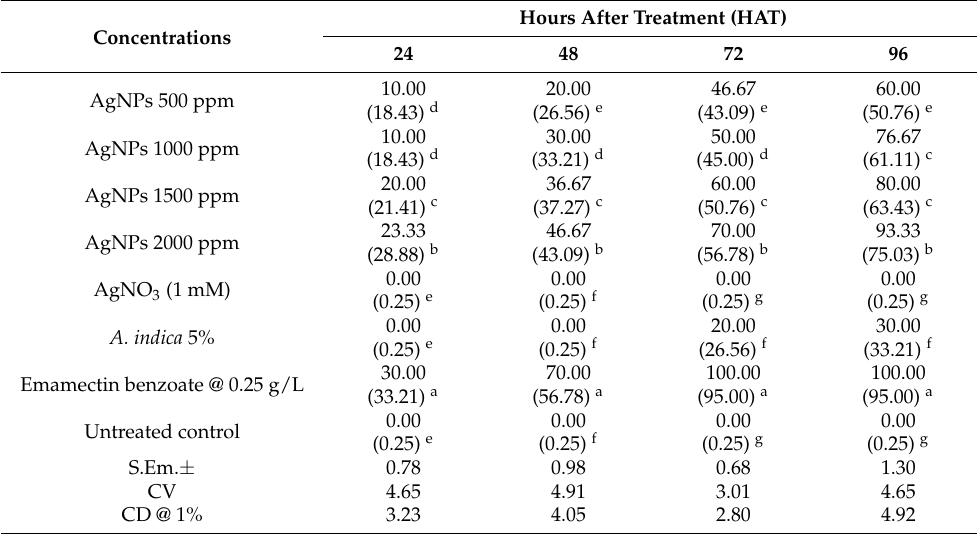
Table 1. Toxicity of green AgNPs. Synthesized from leaves of Azadirachta indica on larval mortality of H. armigera (Instar